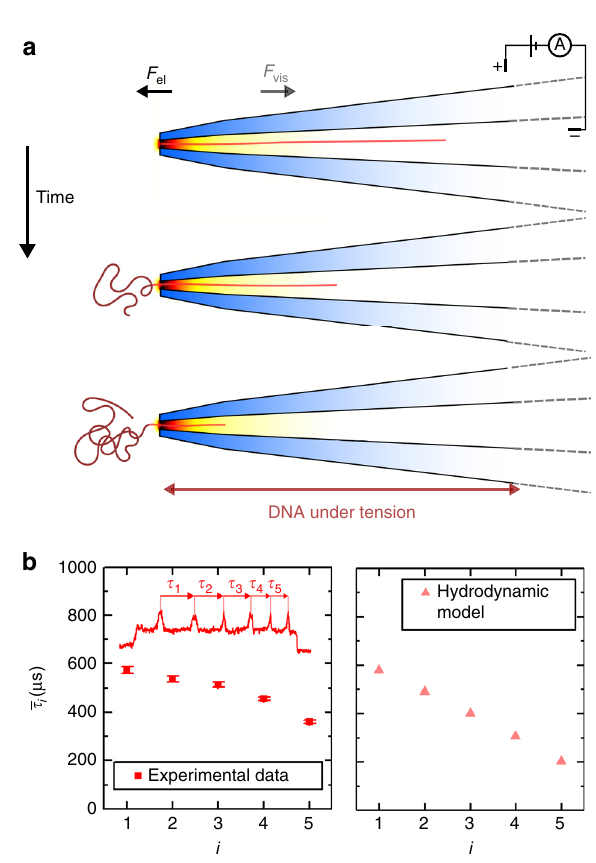
Fig. 6 a Schematic of translocation time course with DNA exiting from con fi nement. The portion of the DNA that has exited the nanopore buckles under a compressive load whereas the section of the DNA inside the nanopore is under tension. b Comparison of model with data on trajectory of DNA exiting nanopore. Errors bars show the standard error of the mean